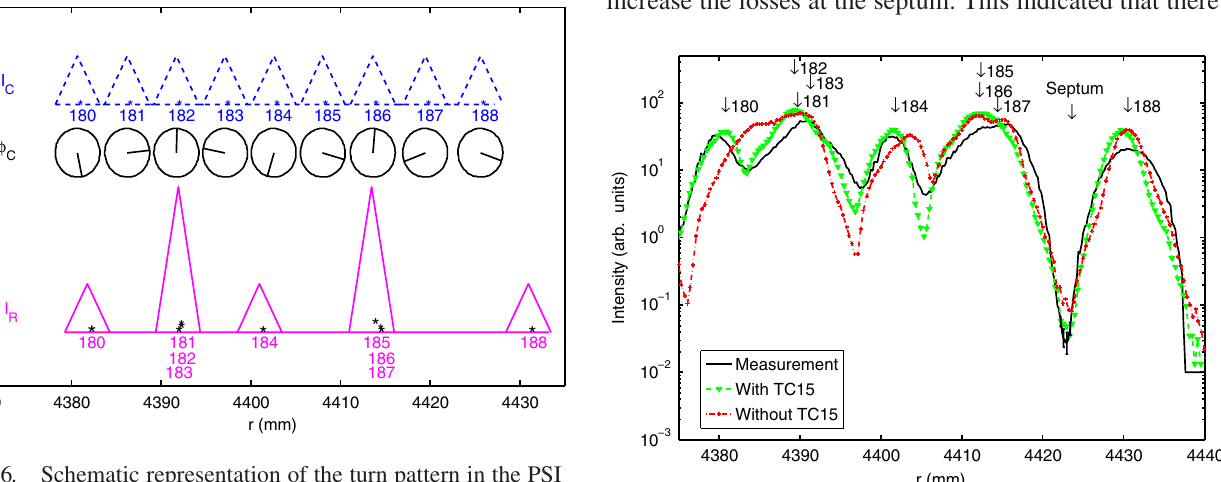
FIG. 6. Schematic representation of the turn pattern in the PSI , (cid:6) , and I represent the intensity distribution Ring cyclotron. I c c r of a centered beam with 6 mm turn separation, the betatron oscillation phase of an eccentric beam, and the intensity distri- bution of a real beam with eccentric injection.